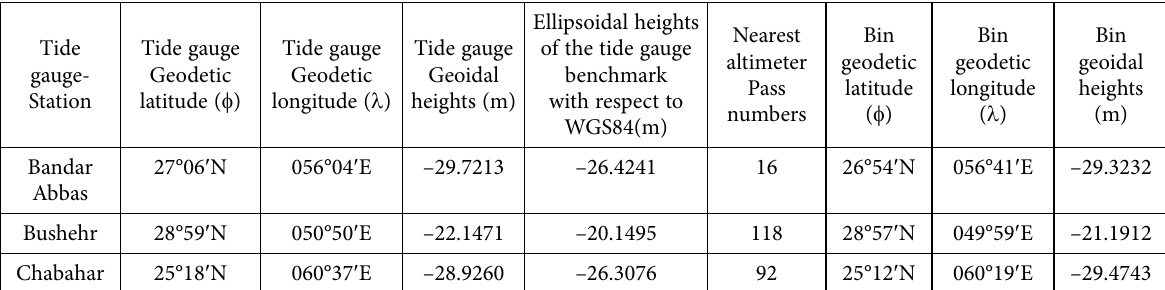
Table 1. A summary of general information corresponding to the study tide gauge stations and their associating altimetry ground tracks and